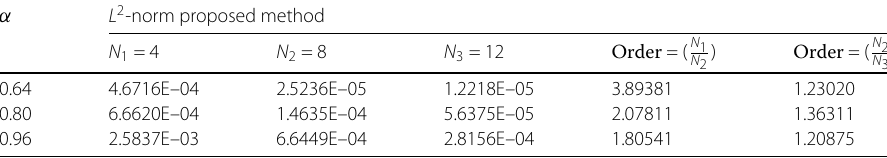
, τ = 1 at T = 1 for Problem 2 N N 2